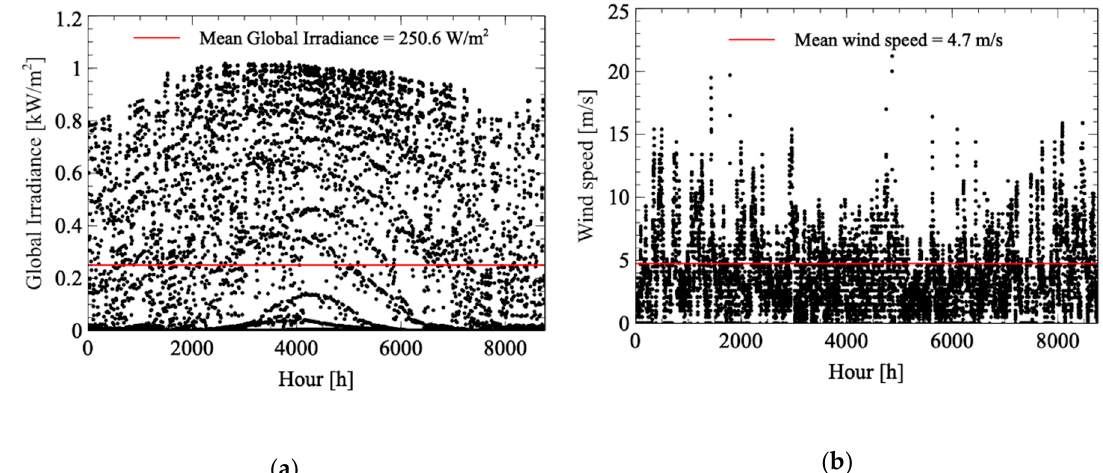
Figure 5. Daily profiles of electric ( a ) and thermal ( b ) power request of a single dwelling during a typical day in winter, summer and intermediate seasons in Southern Italy.